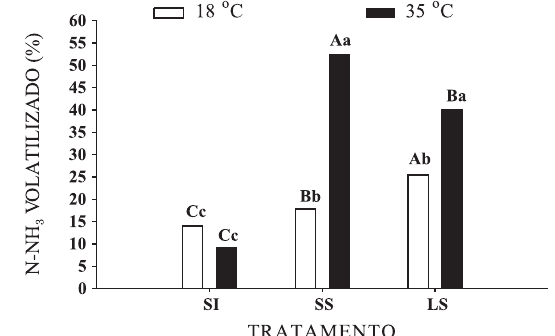
Figura 3. Volatilização de NH do solo após a 3 aplicação de ureia convencional ou de ureia com inibidor de urease nas formas sólida incorporada (SI) ou sem incorporação (SS), ou líquida sobre a superfície (LS), em ambiente mantido a 18 ou a 35 o C. Médias das duas fontes de N. Letras maiúsculas comparam as médias dos tratamentos para a mesma temperatura, enquanto as letras minúsculas comparam as médias entre as temperaturas para o mesmo tratamento; letras diferentes demonstram diferenças entre as variáveis analisadas.